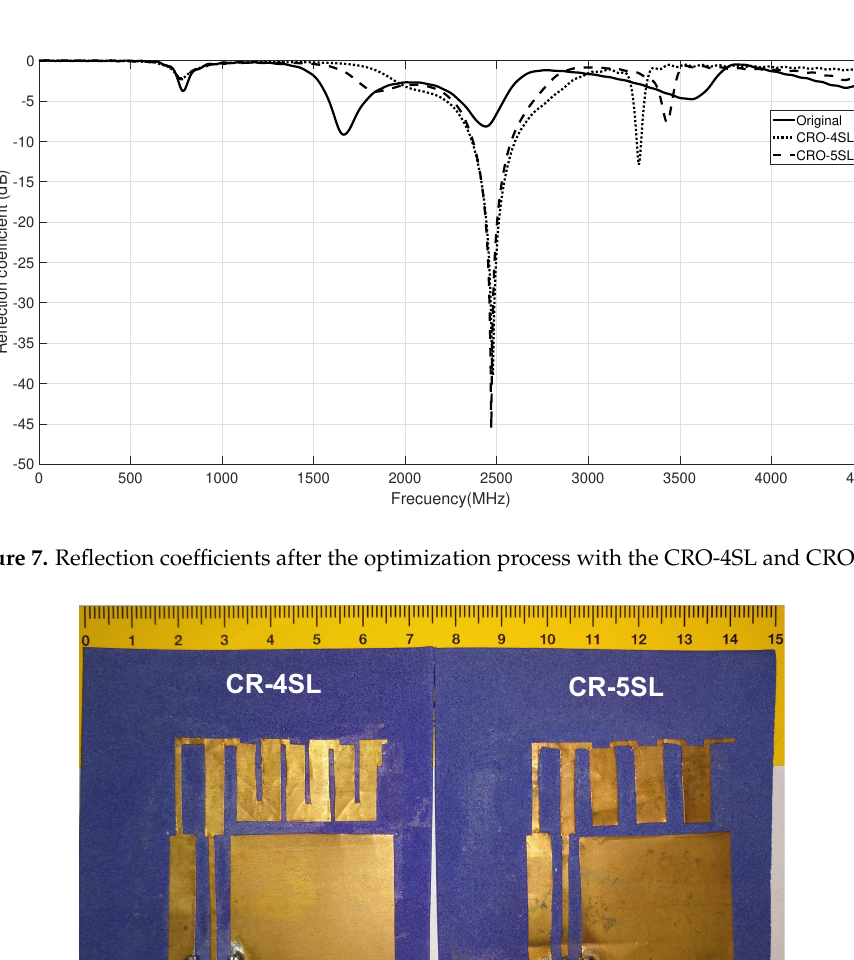
Figure 6. Original (dashed-line) and optimized MS-IFA (grey surface).